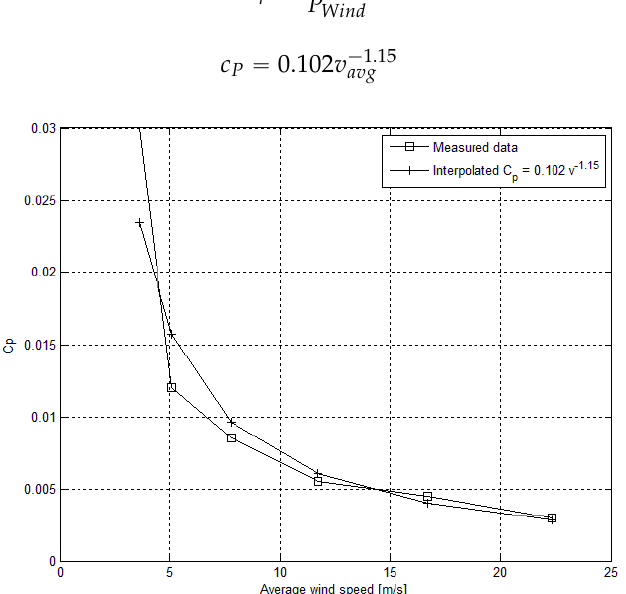
Figure 4. Average wind speed vs. power factor c p .